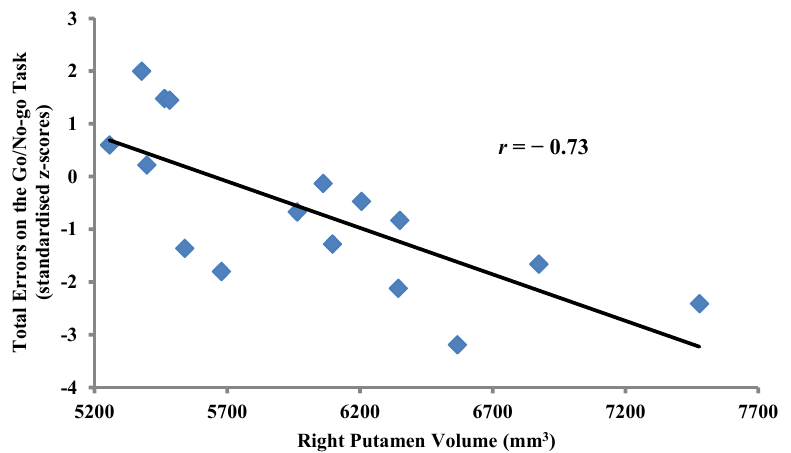
Figure 2. Inverse correlation between right putamen volume and total errors on the Go/No-go task (standardised z-scores) in MA-dependent participants ( n = 17, Pearson’s r = − 0.73, p =